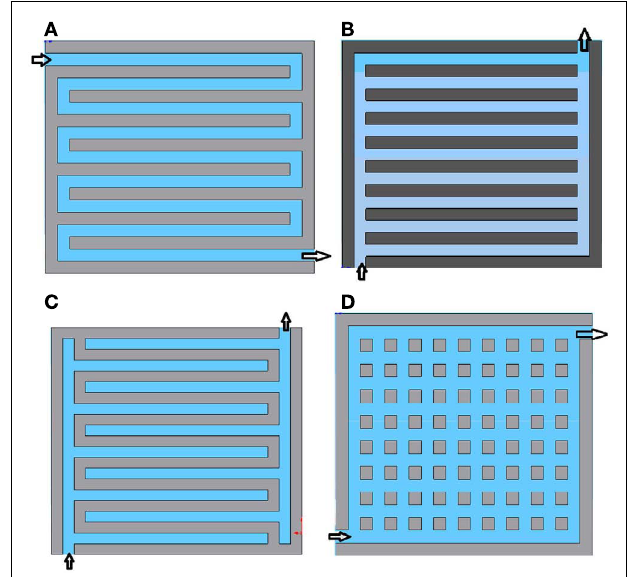
FIGURE 1 |Typical flow channels designs leading to other versions of flow channel designs . (A) Serpentine; (B) Parallel; (C) Interdigitated; (D) Pin.